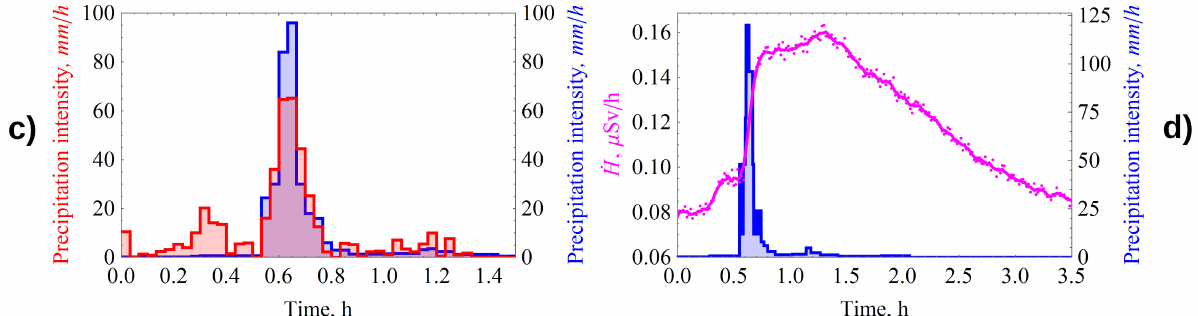
Figure 6. Dynamics of the measured precipitation intensity (blue) and time derivative of the measured dose rate (red) without smoothing ( a ), with smoothing by moving average ( b ), with averaging over 2 min ( c ), gamma dose rate (pink) ( d